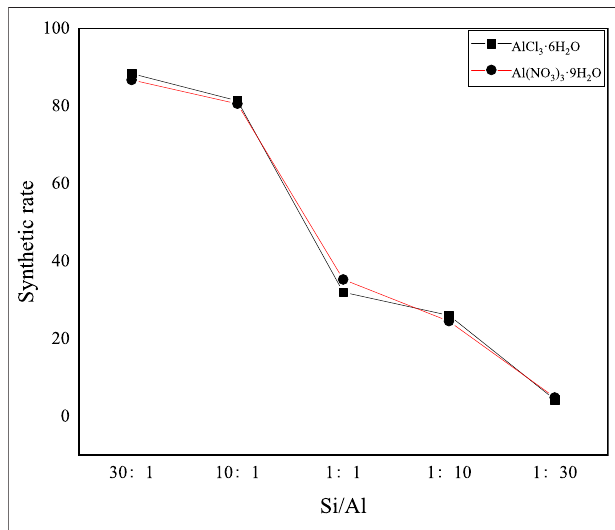
FIGURE 2 | Curve of synthesis rate of synthetic precursors under different aluminum source conditions.